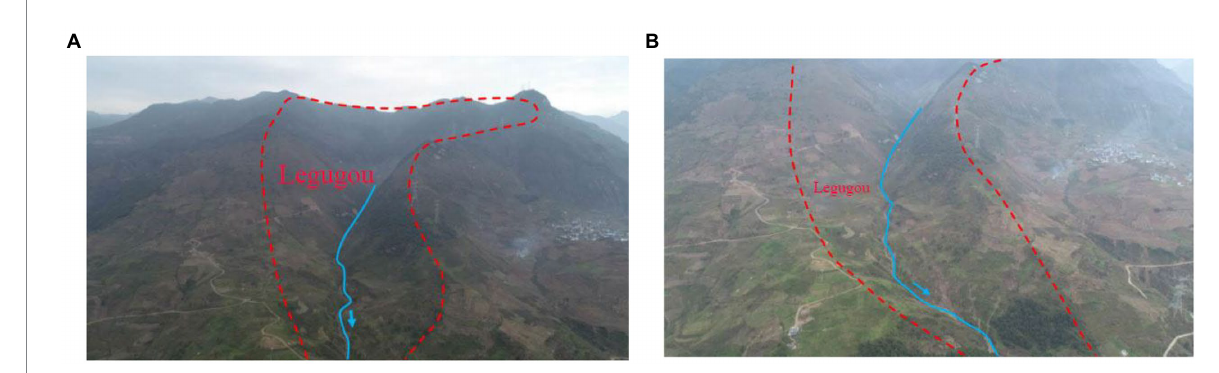
FIGURE 4 Geomorphological conditions of Legugou watershed. (A) Geomorphological conditions in the upper part of the watershed. (B) Geomorphological conditions in the middle part of the